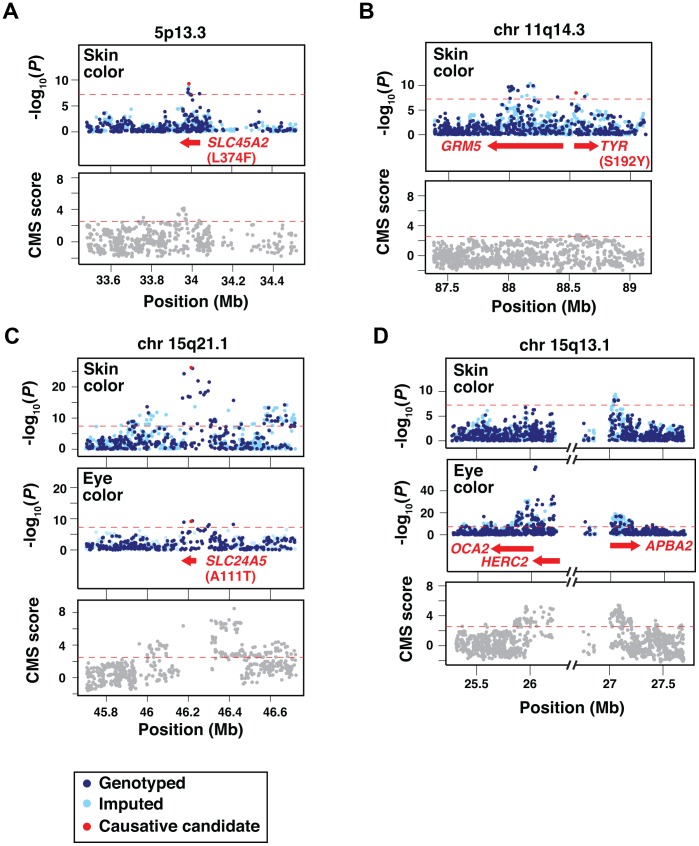
Imputation, fine-mapping, and selective signature scores for skin and eye color loci.Each panel shows the genotype-association results and the distribution of Composite of Multiple Signals scores of positive selection (CMS scores) [38] for genotyped and imputed SNPs (dark and light blue points in the association plots, respectively) surrounding the candidate loci; identities of individual SNPs are given in Table 1. Dashed red lines correspond to the genome-wide significance thresholds. (a) 5p13.3 region containing the SLC45A2 gene. (b) 11q14.3 region containing the GRM5 and TYR genes. (c) 15q21.1 region containing the SLC24A5 gene. (d) 15q13.1 region containing the OCA2, HERC2 and APBA2 genes. The interval between HERC2 and APBA2 contains a cluster of segmental duplications and a paucity of SNPs [45], and is also a source of a frequent deletion breakpoint as described in the Discussion. Previously identified candidate causative non-synonymous variants [11], [13], [14] are denoted as red dots in the association plots of panels (a,b,c). The location and identity of candidate genes are colored to correspond with chromosomal location; individual SNPs are given in Table 1.